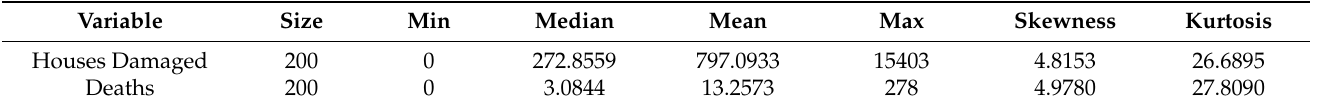
Table 1. Descriptive statistic of houses damaged and deaths.